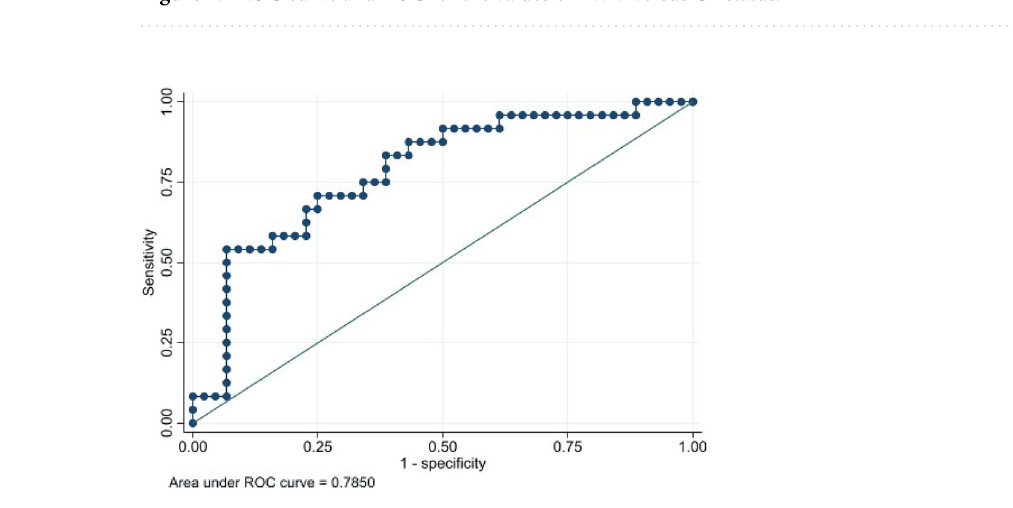
Figure 1. ROC curve and AUC for the values of PWV versus CP status.